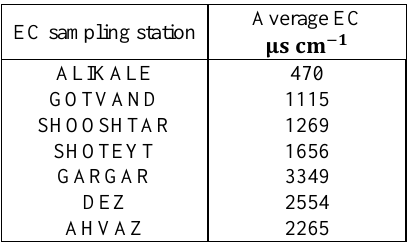
Figure 2. Spectral signature of salty water for each